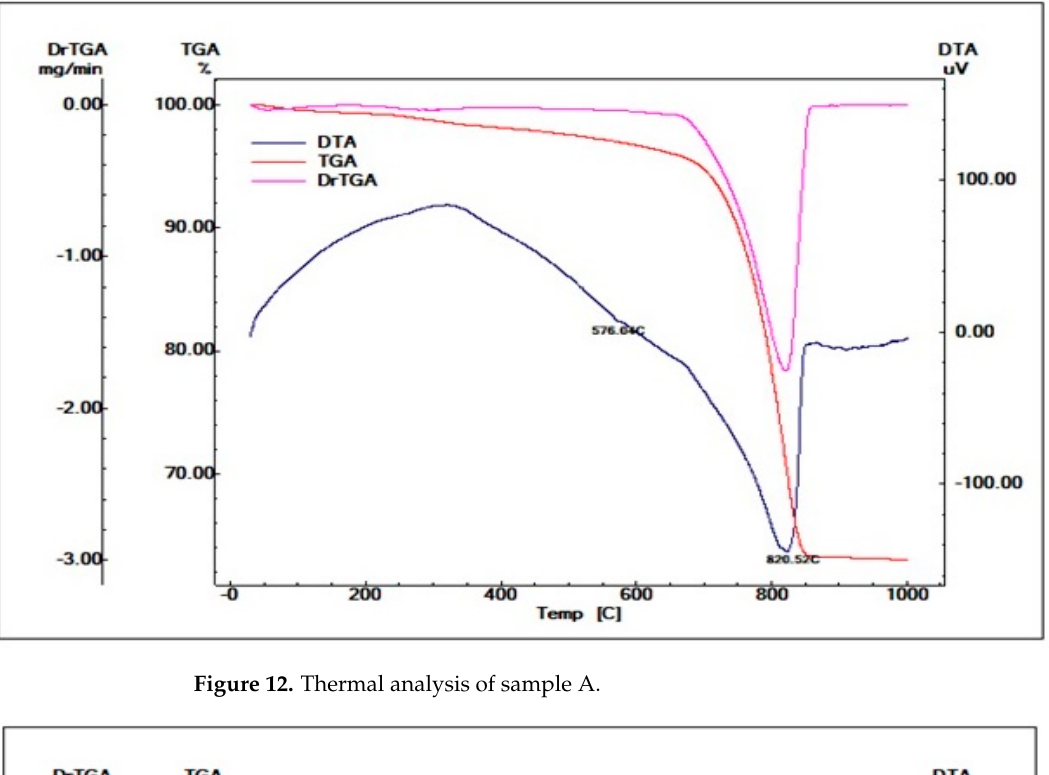
Figure 12. Thermal analysis of sample A.